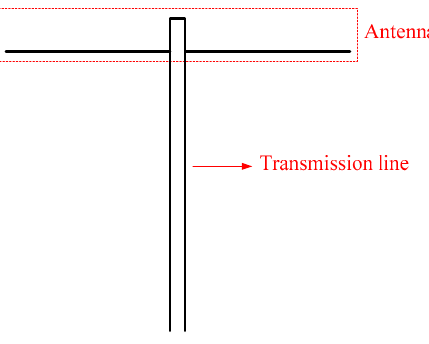
Figure 5. Layout of the proposed T-type antenna.